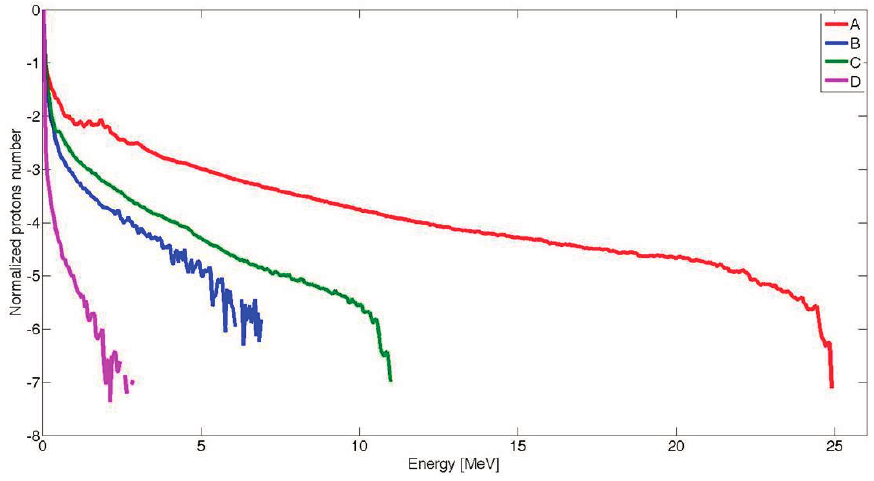
Figure 7. Simulated proton energy spectra for the cases defined in Figure